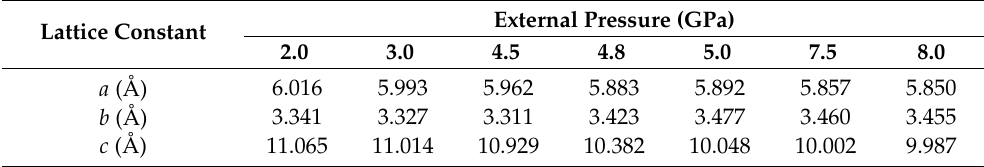
Table 4. Lattice constants (Å) of Fe 3 Se 4 under isotropic external pressure (GPa).